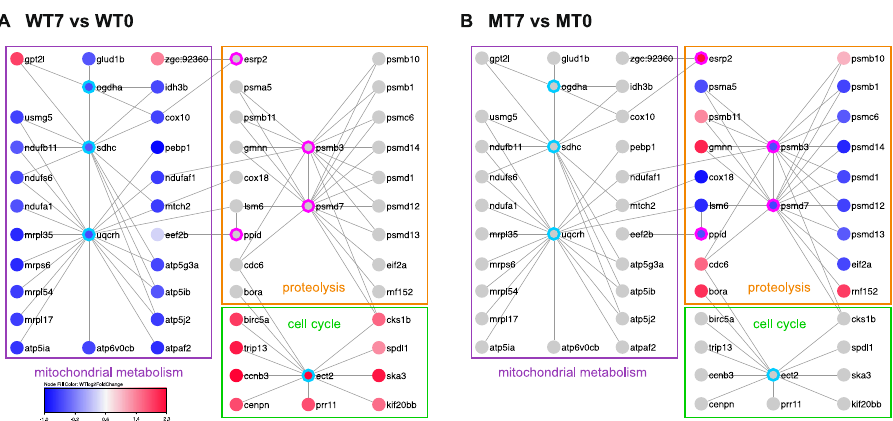
Fig. 6 Network analysis of Nkx2.5 targets reveals distinct nodes that coordinate GRNs governing regenerative pathways. A , B Network analyses of DamID targets in set A (turquoise border) and set B (magenta border). Color represents the fold change in injured compared to uninjured wild-type CMs (WT7 vs WT0) ( A ) and injured compared to uninjured nkx2.5 − / − CMs (MT7 vs MT0) ( B ). Red is upregulated and blue is downregulated, as shown in the key. Mitochondrial metabolism modules are labeled in purple, proteolysis modules are labeled in orange, and cell cycles modules are labeled